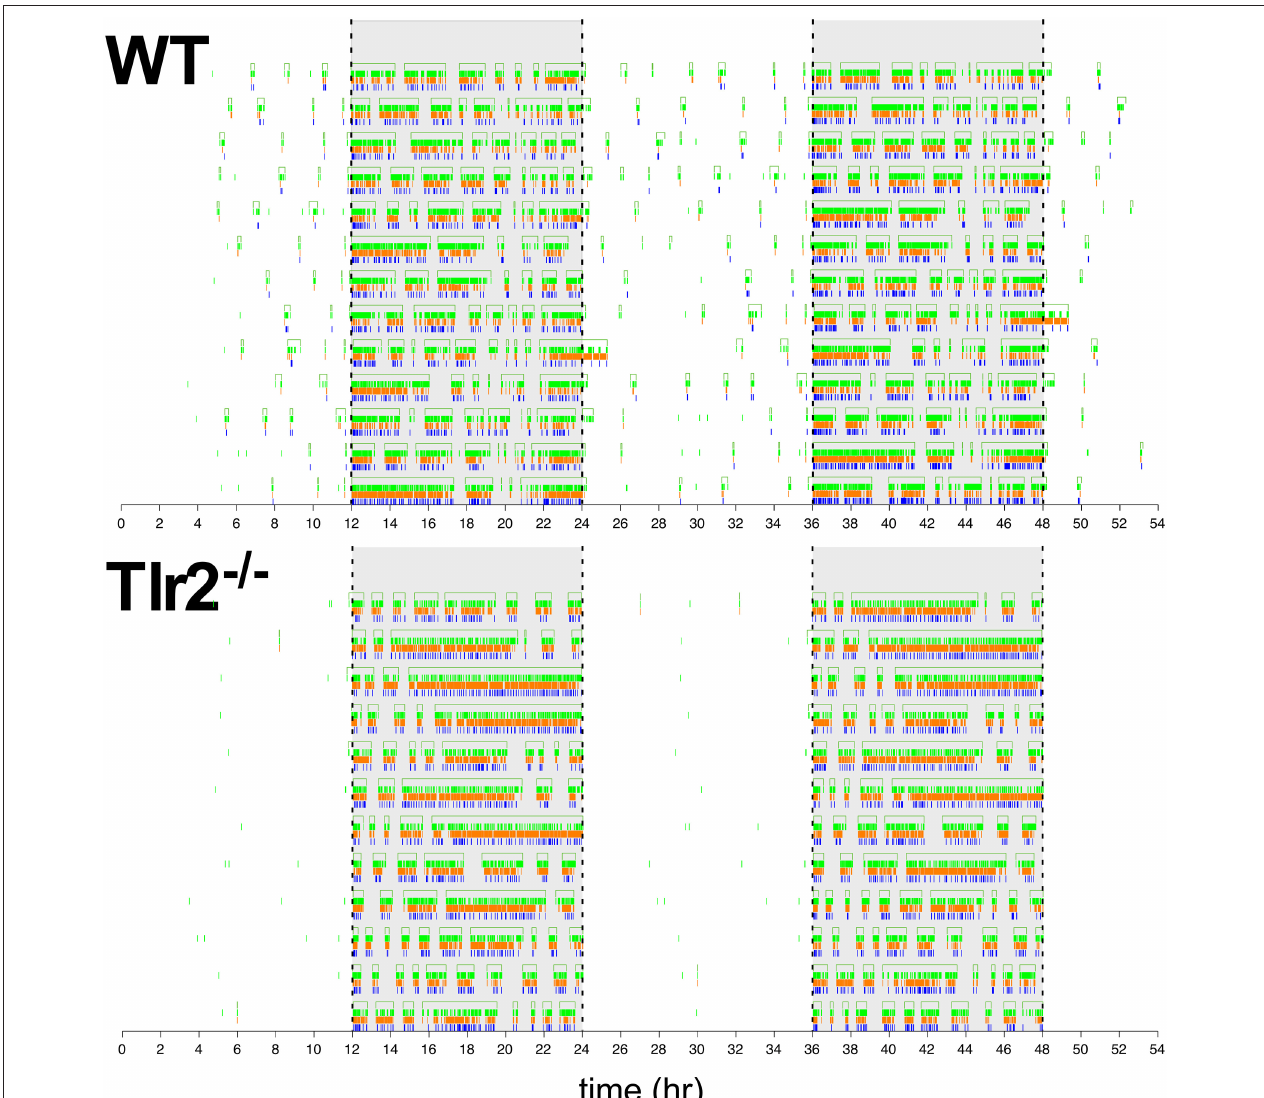
FIGURE 4 | Dual plot actogram demonstrating dark cycle active state consolidation and light cycle inactive state consolidation of a representative Tlr2 − / − mouse in comparison to a representative WT mouse. X axis depicts military time (lights off at 12:00 and 36:00, lights on at 24:00 and 48:00) in hours. Y axis depicts experimental day. Note that the data shown in the last half of one daily trace is the first half of data shown in the following day (except for the last day of collection). Drinking, feeding, and movement events are depicted by blue, orange, and green hash lines, respectively. The empty rectangles at the top of tracings for each day represent duration of calculated active states. Dashed vertical lines show lighting transitions, gray background depicts dark